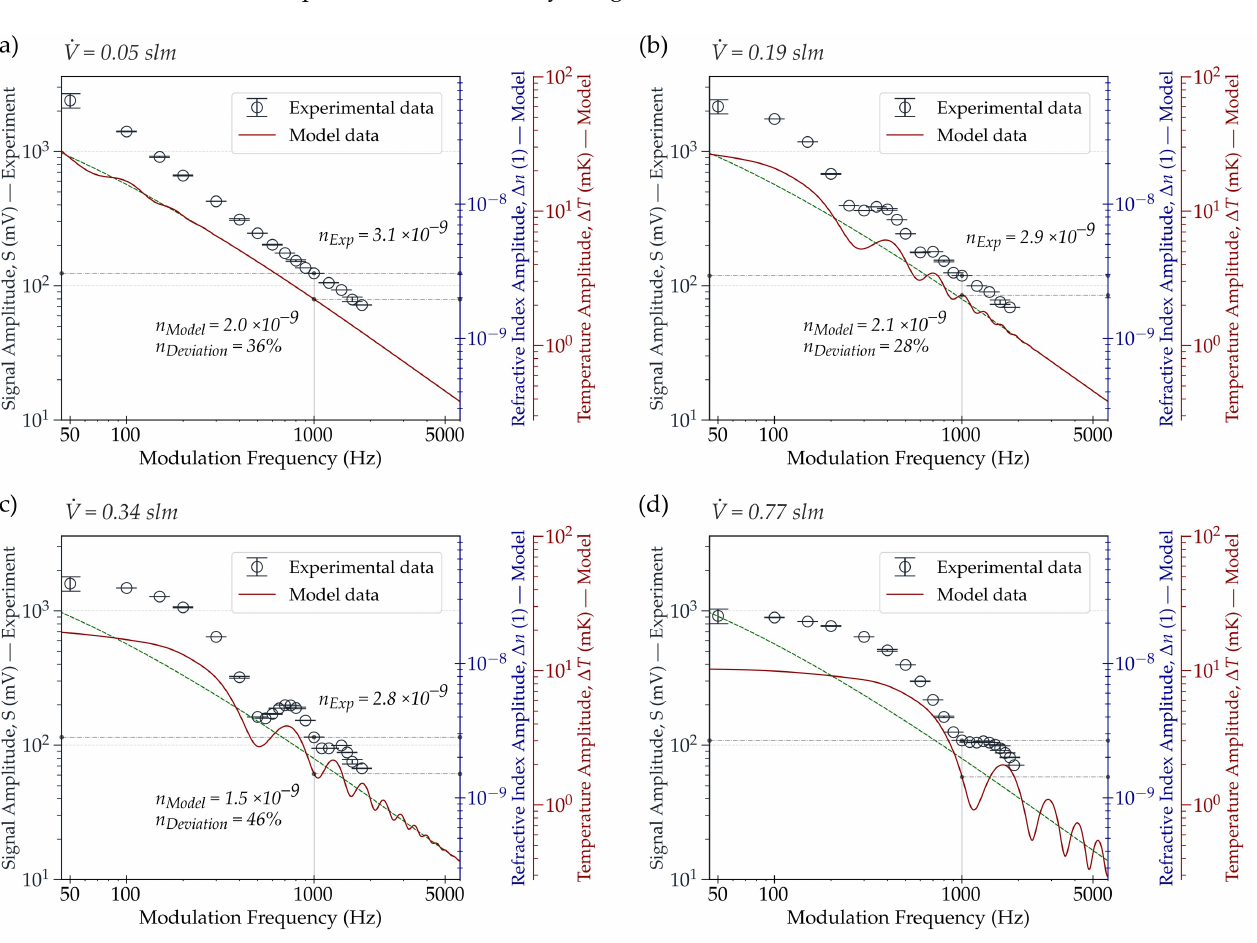
Figure 7. Experimental (circles) and numerical simulation (solid red line) frequency sweep for four selected flow rates. The model features amplitude variations oscillating around a zero-flow baseline (dashed green line) that increase in intensity for higher ˙ V (from ( a – d )). Variations in amplitude are experimentally not observable for the lowest ˙ V ( a ) but become distinctly noticeable towards higher ˙ V . Deviations between experiment and model in amplitude (for all ˙ V ) and oscillation position (for high ˙ V ) are attributable to parameter uncertainties in the model (e.g., flow velocity distribution) and engineering constraints in the experimental setup (e.g., PT cell imperfections). The measured values (in mV) are convertible into ∆ n and ∆ T at 1 kHz via the given sensitivity of the FPI